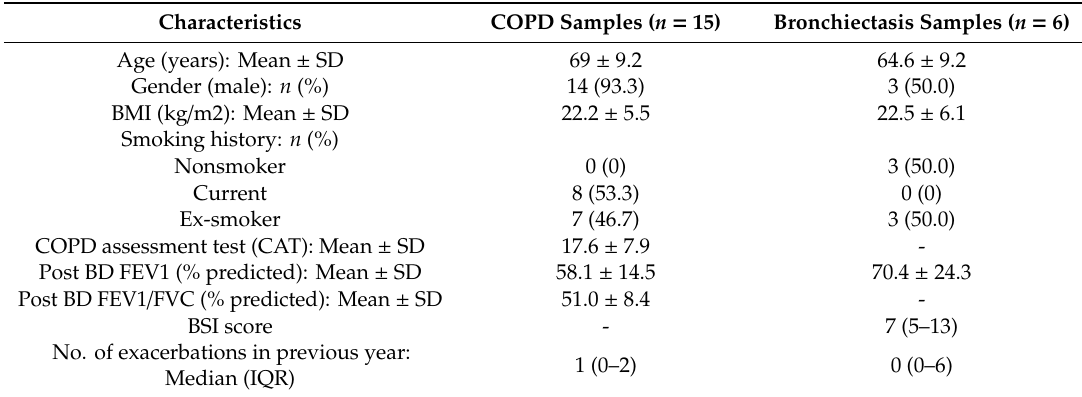
Table 4. Demographics of the study population used in this study. All COPD and bronchiectasis patients were recruited in Singapore. Data are presented as mean or median (and standard deviation, SD or interquartile range, IQR) or n (percentage; %). Post BD: post bronchodilator; BMI: Body